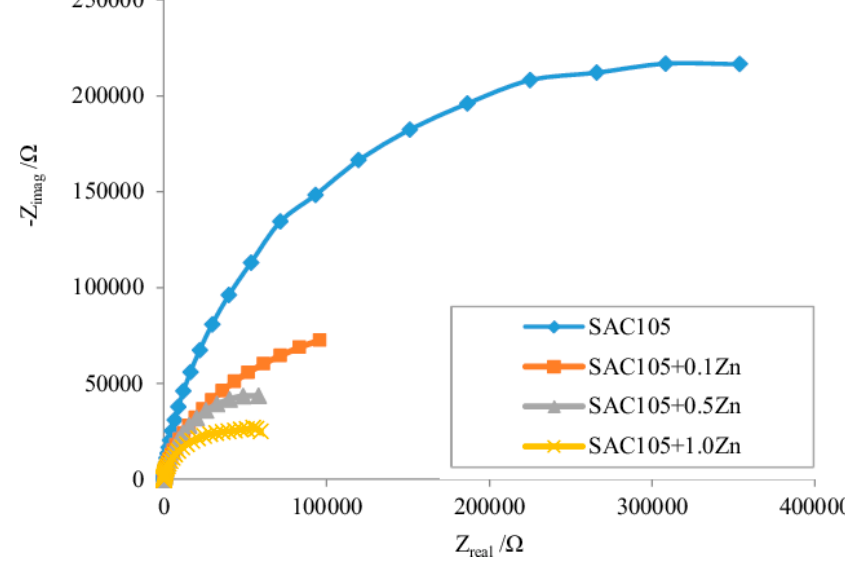
Figure 2. Nyquist plot for SAC105- X Zn ( X = 0, 0.1, 0.5, 1 wt %) solder alloys in 3.5 wt % NaCl solution [55].